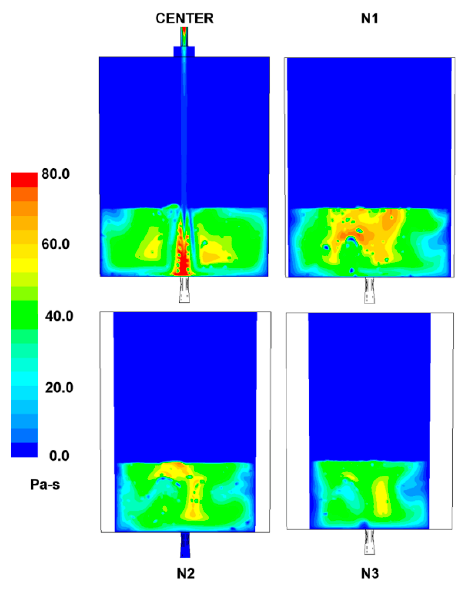
Figure 9. Fields of Turbulent viscosity (Pa-s) in planes of the North sector at a bath level of 30 tons.